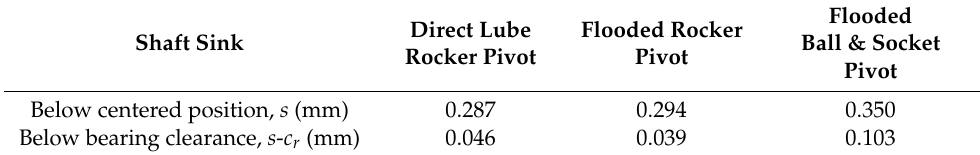
Table 5. Geometric Shaft Sink.